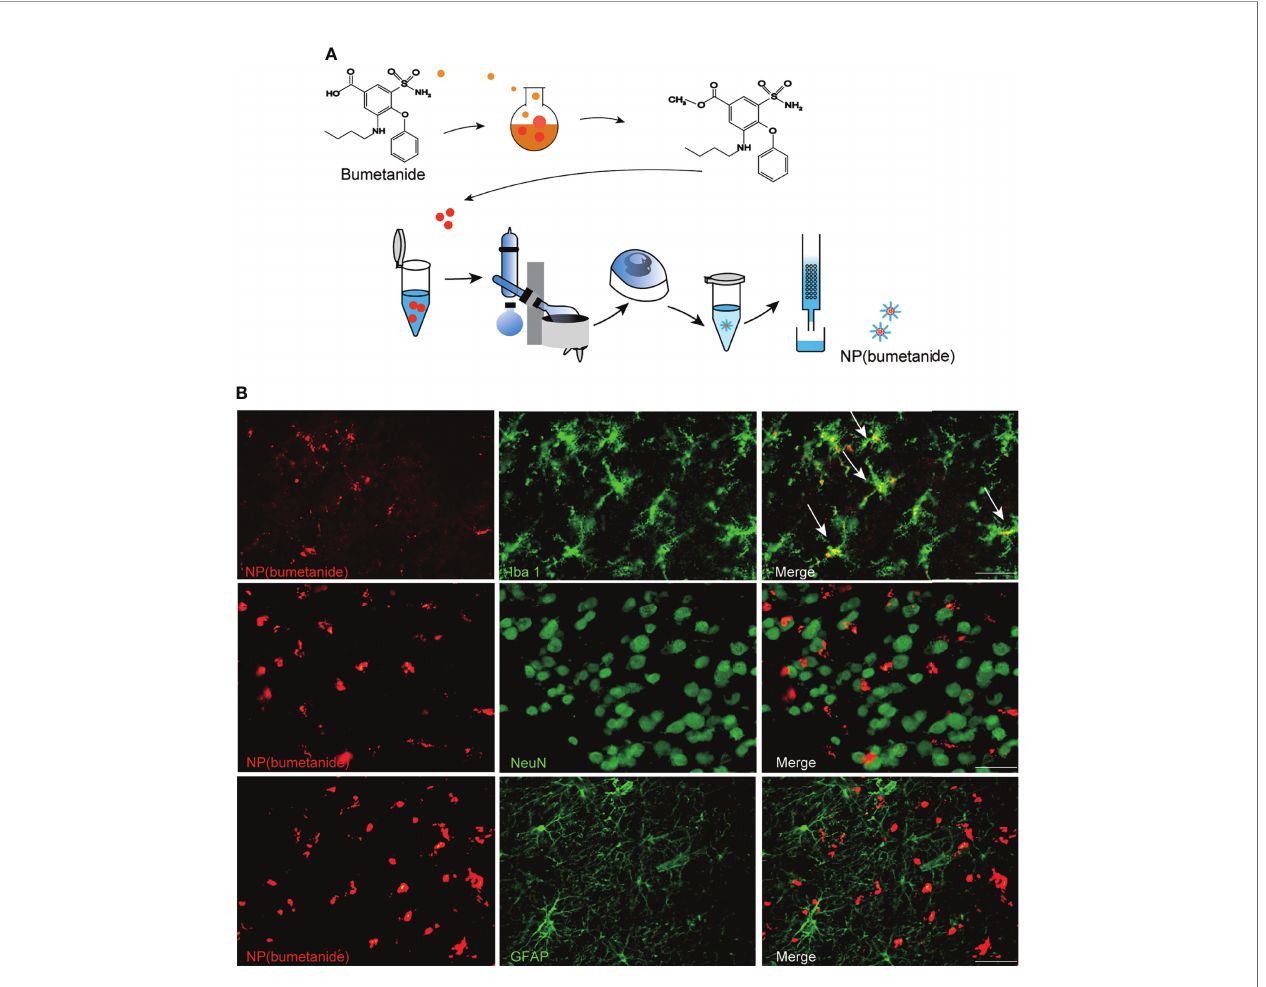
FIGURE 3 | NP(bumetanide) selectively targeting microglia of mPFC in vivo . (A) Schematic representation of the nanoformulated bumetanide experimental procedure. (B) Representative images of the fl uorescence staining. NP(bumetanide) (Rhodamine-label, Red), microglia (Iba1, Green), Neuron (NeuN, Green), and astrocyte (GFAP, Green) and merged image in mPFC slices of BTBR mice, and co-localization of NP (bumetanide) and Iba1 are shown as arrow. Scale bar 100 m